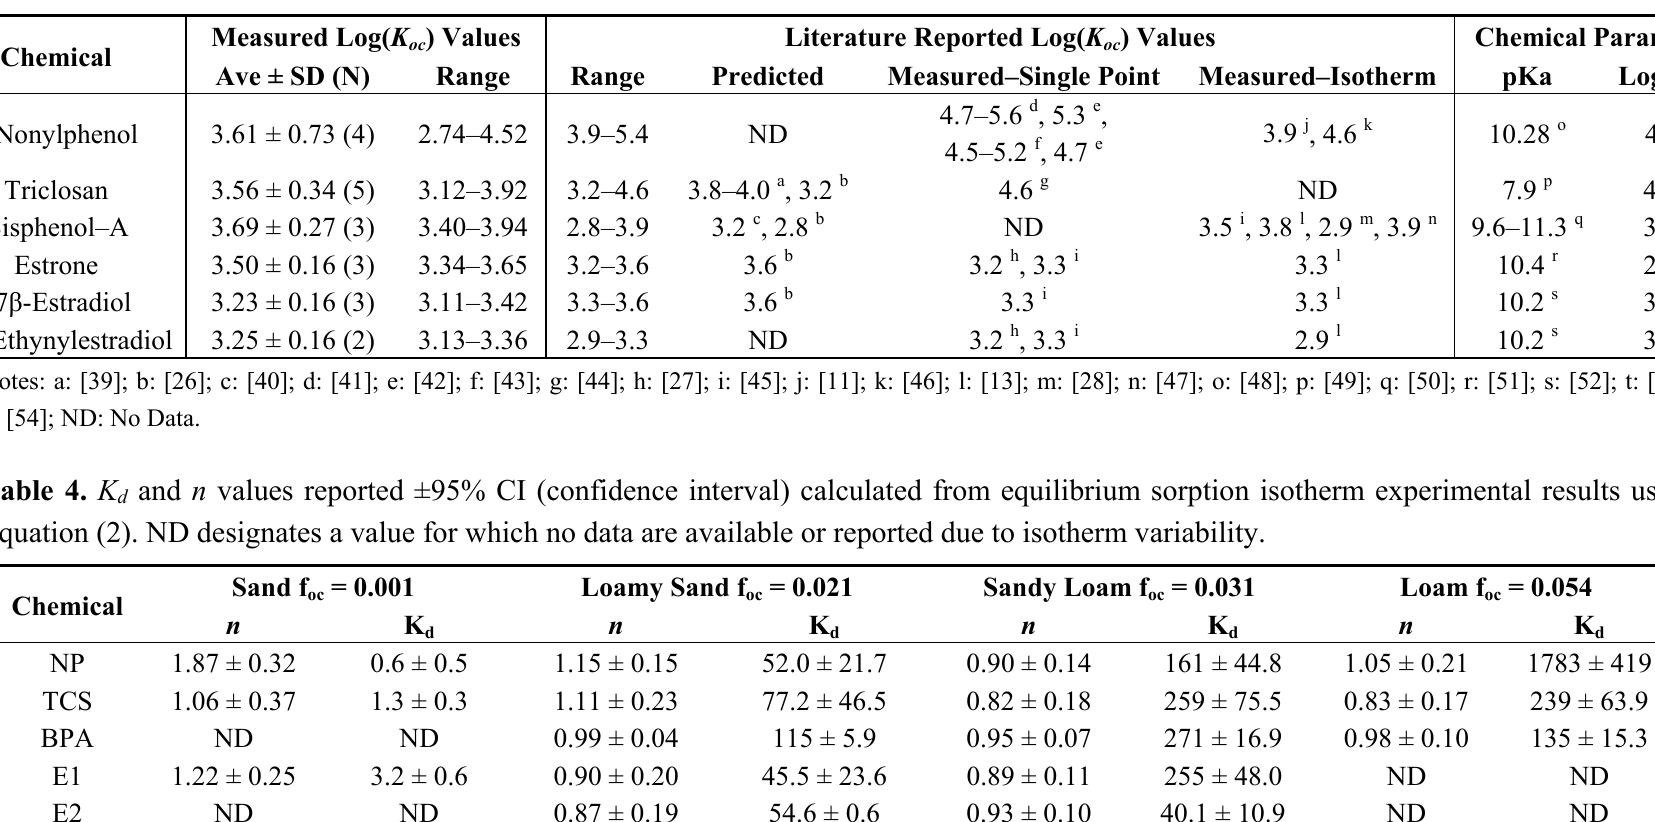
values reported in the oc